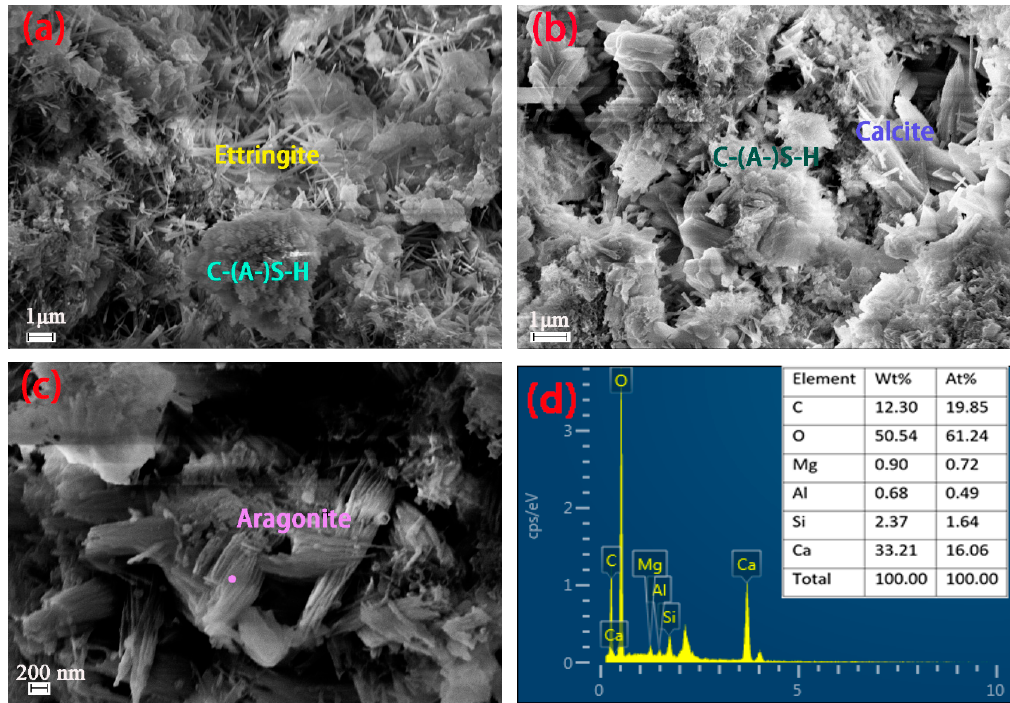
Figure 8. SEM images of the U4 ( a ), C4 ( b ), and C1 ( c ) samples at 28 d of curing. ( d ) EDS result for the point shown in ( c